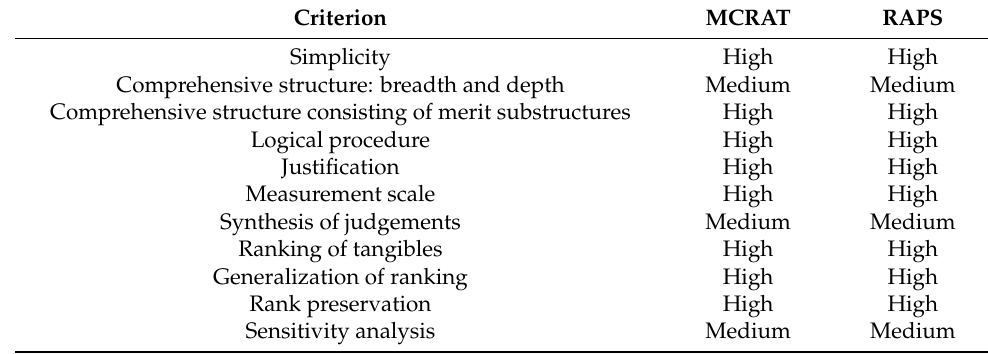
Table 21. Evaluation of MCRAT and RAPS